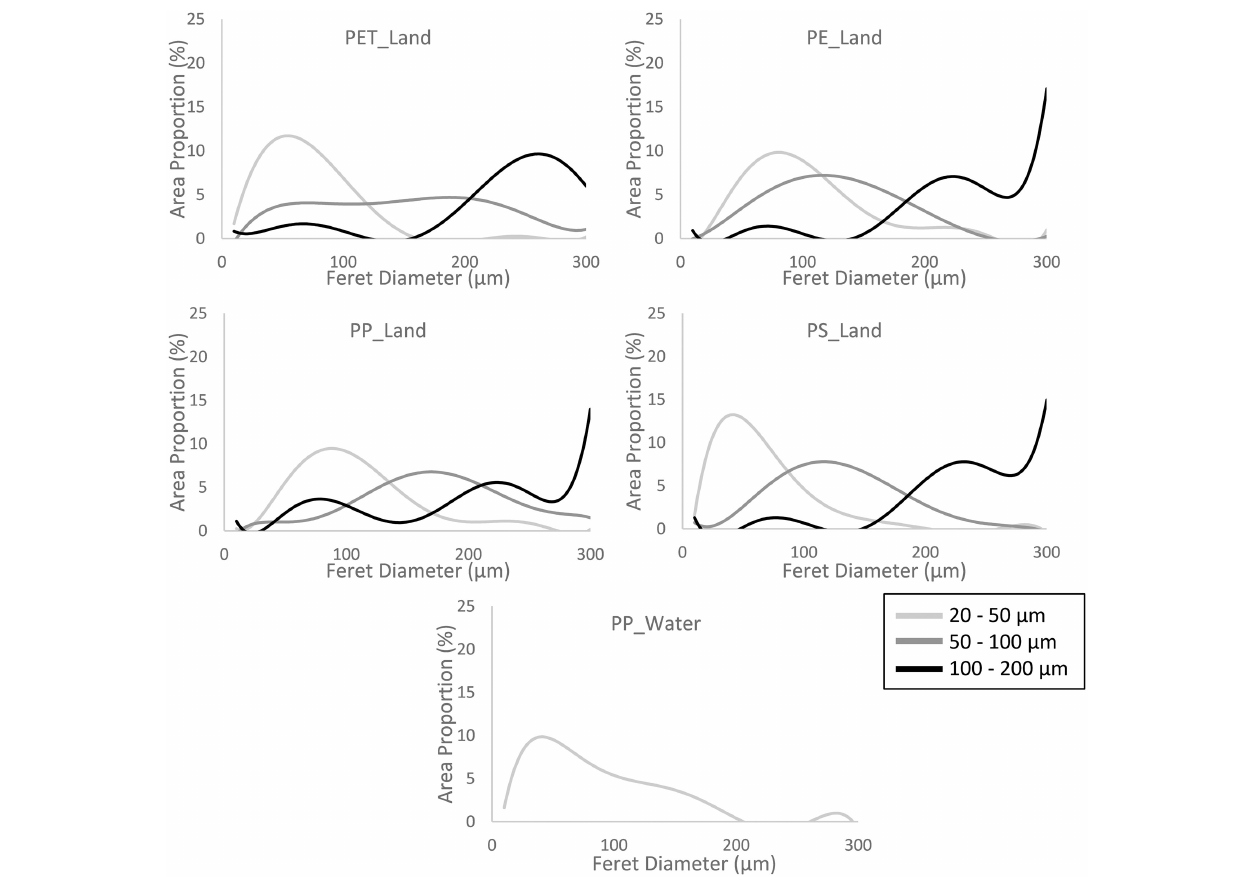
FIGURE 3 | Particle size distribution. The graphs represent the distribution of Feret diameters between 1 and 300 µ m. The height of the curves represent the fraction of the sum of the 2-dimensional projection surface area of all particles within 1 bin (data divided in bins of 10 µ m) relative to the sum of all particles measured per sample. The number of particles analyzed per sample ranged between 112 and 419. The sample PP_Water consist of 1 size fraction, namely < 300 µ m. See Supplementary Table 1 for raw